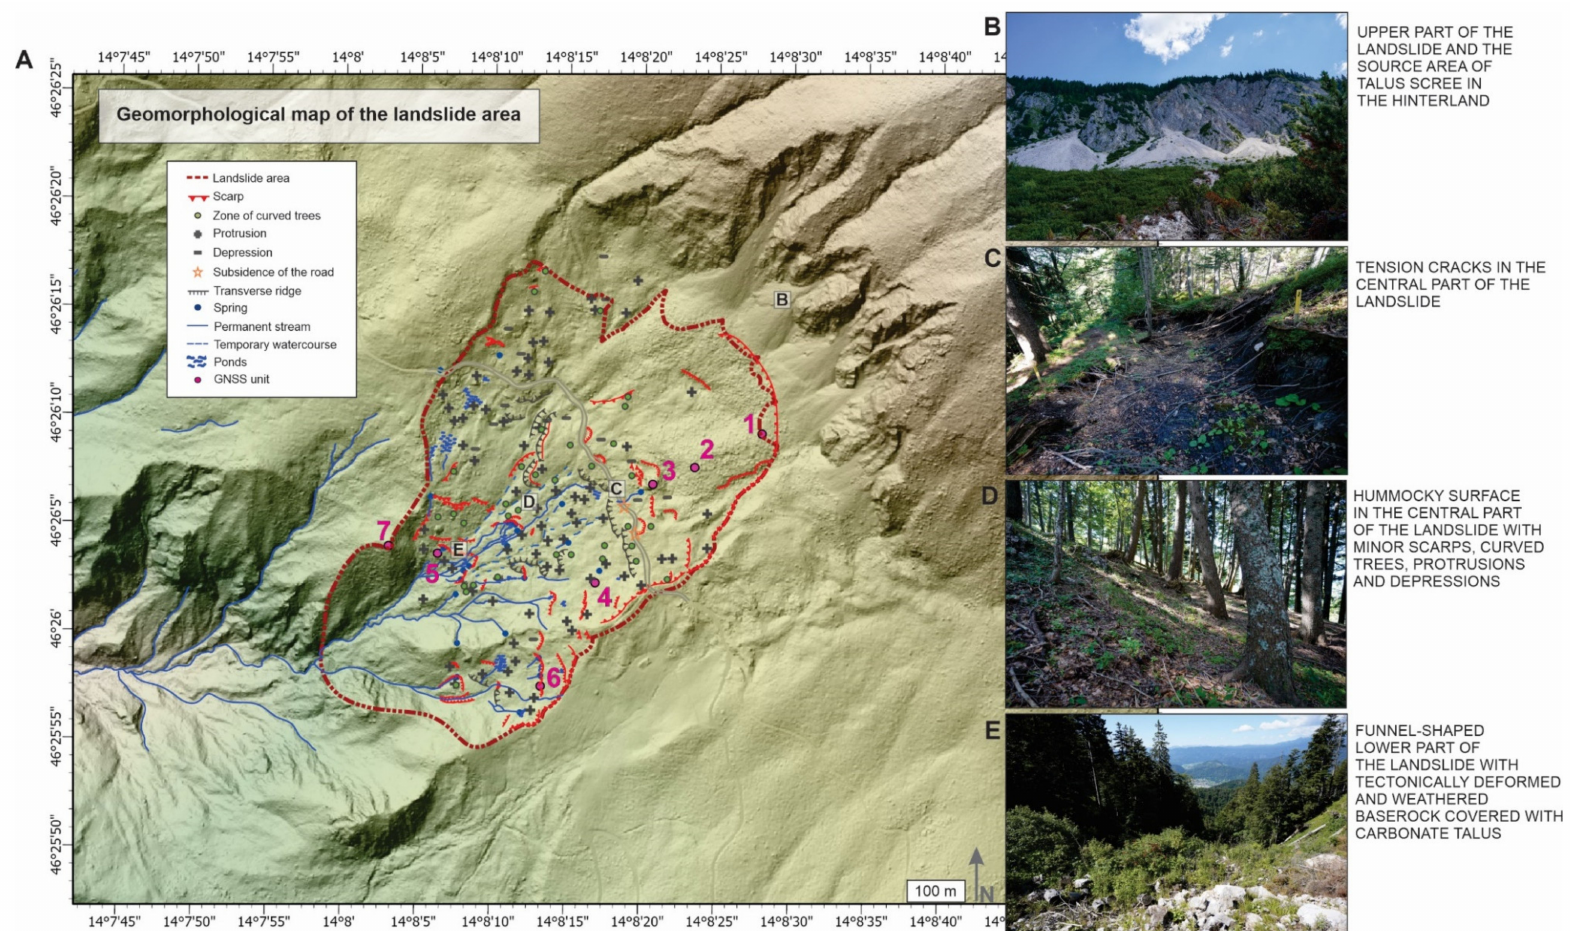
Figure 7. ( A – E ) Geomorphological map of the landslide area and main characteristics of the monitoring